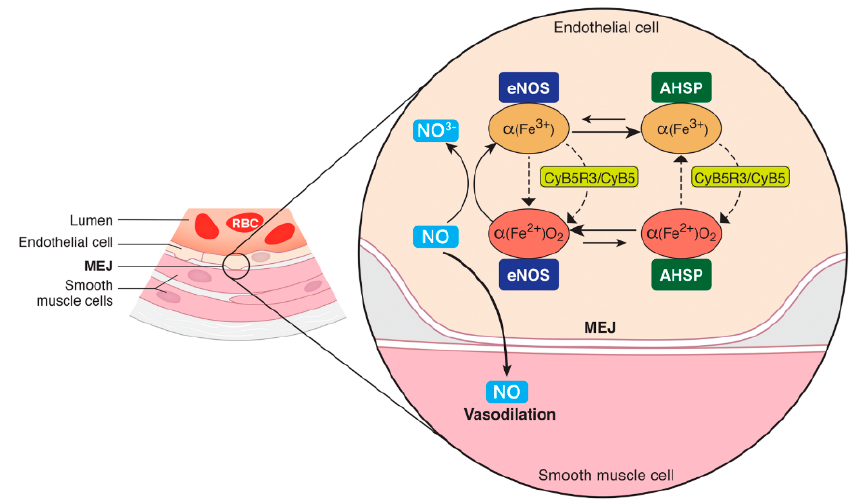
Figure 4. Model for regulation of NO metabolism by α -globin in the myoendothelial junction (MEJ) of vascular endothelial cells. After translation, newly formed apo– α -globin subunits bind to their partner subunit, AHSP, or, to a lesser extent, eNOS. AHSP can bind to both reduced (Fe 2+ ) and oxidized (Fe 3+ ) α -globin. In the reduced complex, the heme group is coordinated with the bound O 2 . O 2 (Fe 2+ ) α -globin interacts with eNOS and degrades NO via dioxygenation or binds AHSP and rapidly becomes oxidized. The oxidized α -globin is catalytically inert, and it is this function of AHSP that protects cells from oxidative damage. However, the specific binding of α -globin by AHSP or eNOS prevents α -globin from precipitating, allowing more time for α -globin to be reduced by eNOS directly or by the CyB5R3/CyB5 system and become